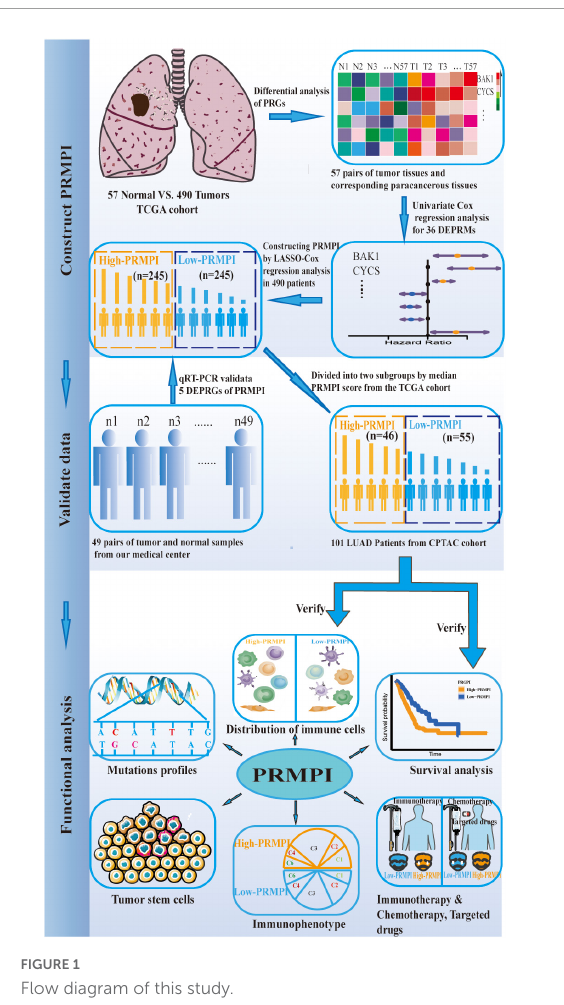
FIGURE1 Flow diagram of this